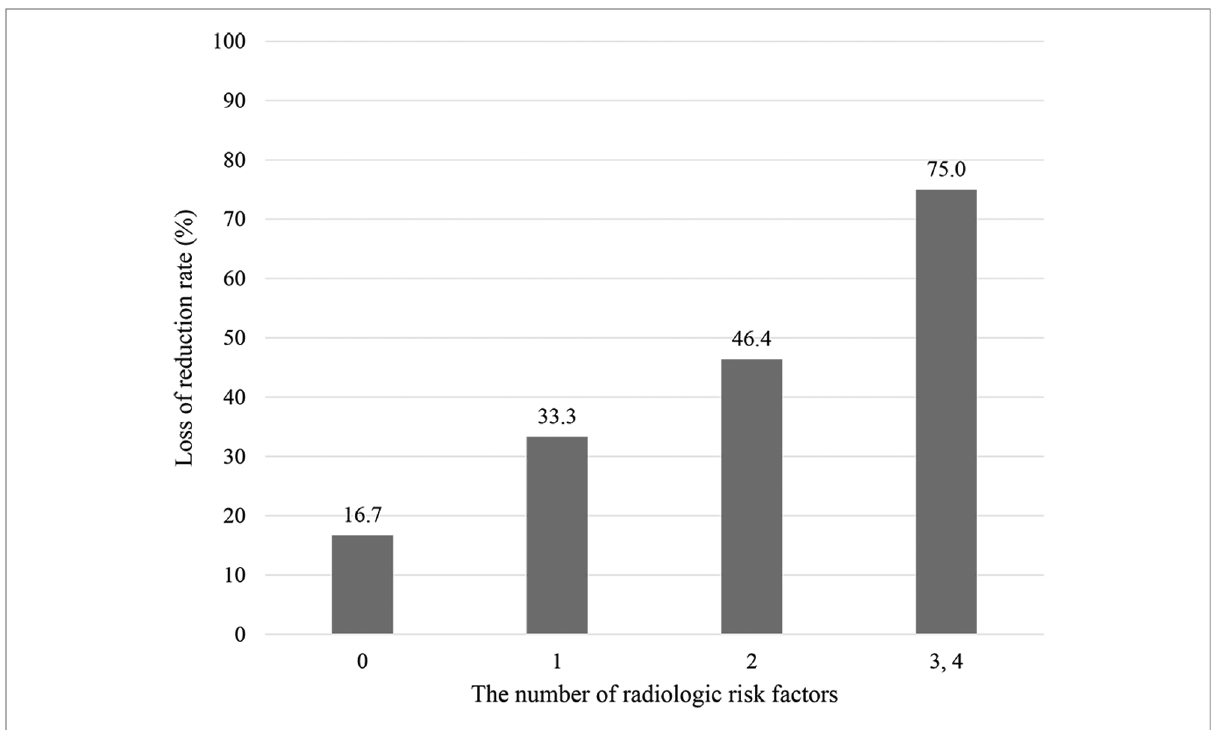
FIGURE 3 Loss of reduction rate according to radiologic risk factors. The horizontal axis indicates the number of radiologic risk factors.